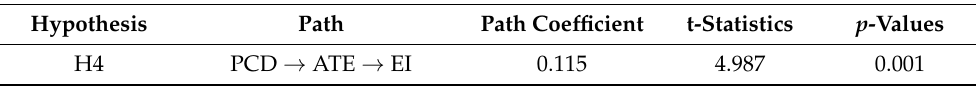
Table 4. Indirect effect.